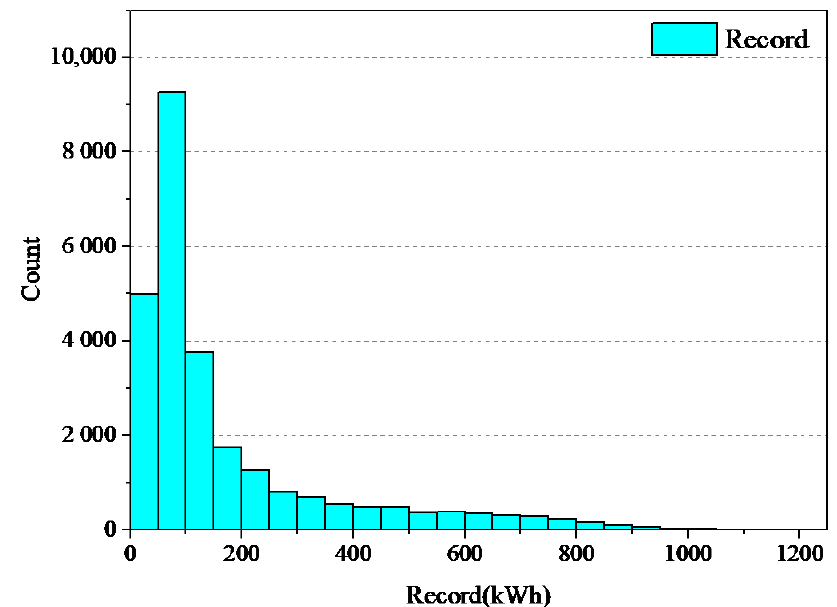
Figure 3. Distribution diagram of the electricity consumption data.